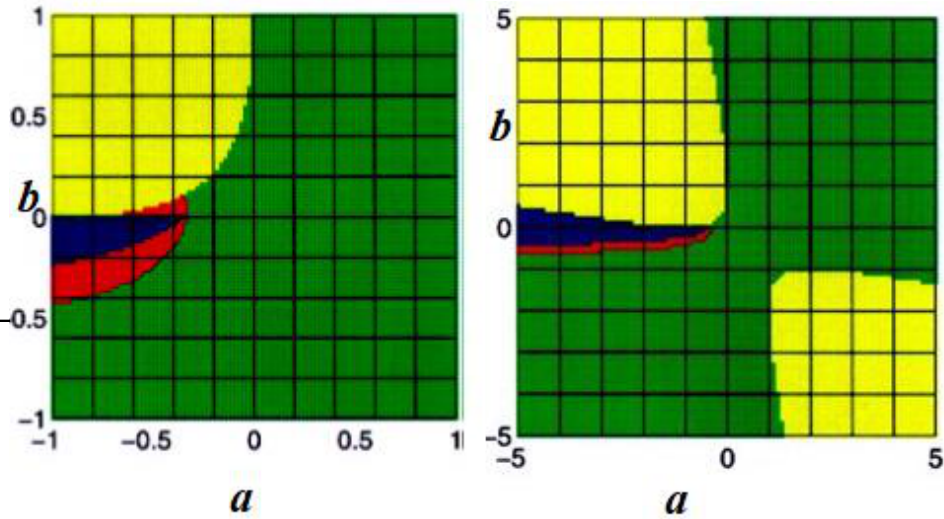
Figure 5. Bifurcation diagrams of the Oregonator model for different sets of cell parameters. The edge of chaos region is shown in red, the locally active and unstable region is given in green, and the locally passive region is blue. In the domain coded with yellow, no equilibrium point exists.